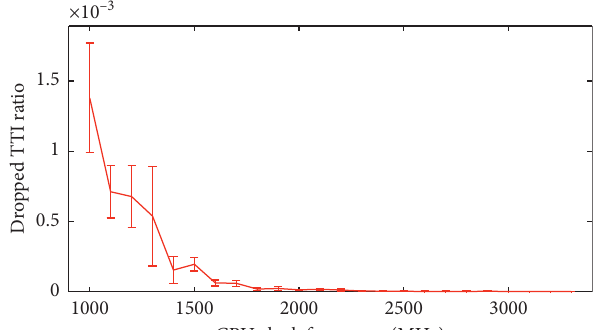
Figure 7: System 2: dropped TTI ratio for each clock frequency value recorded. The red line is the median with the vertical bars depicting ± one standard deviation. 10MHz bandwidth with 25 RB load.